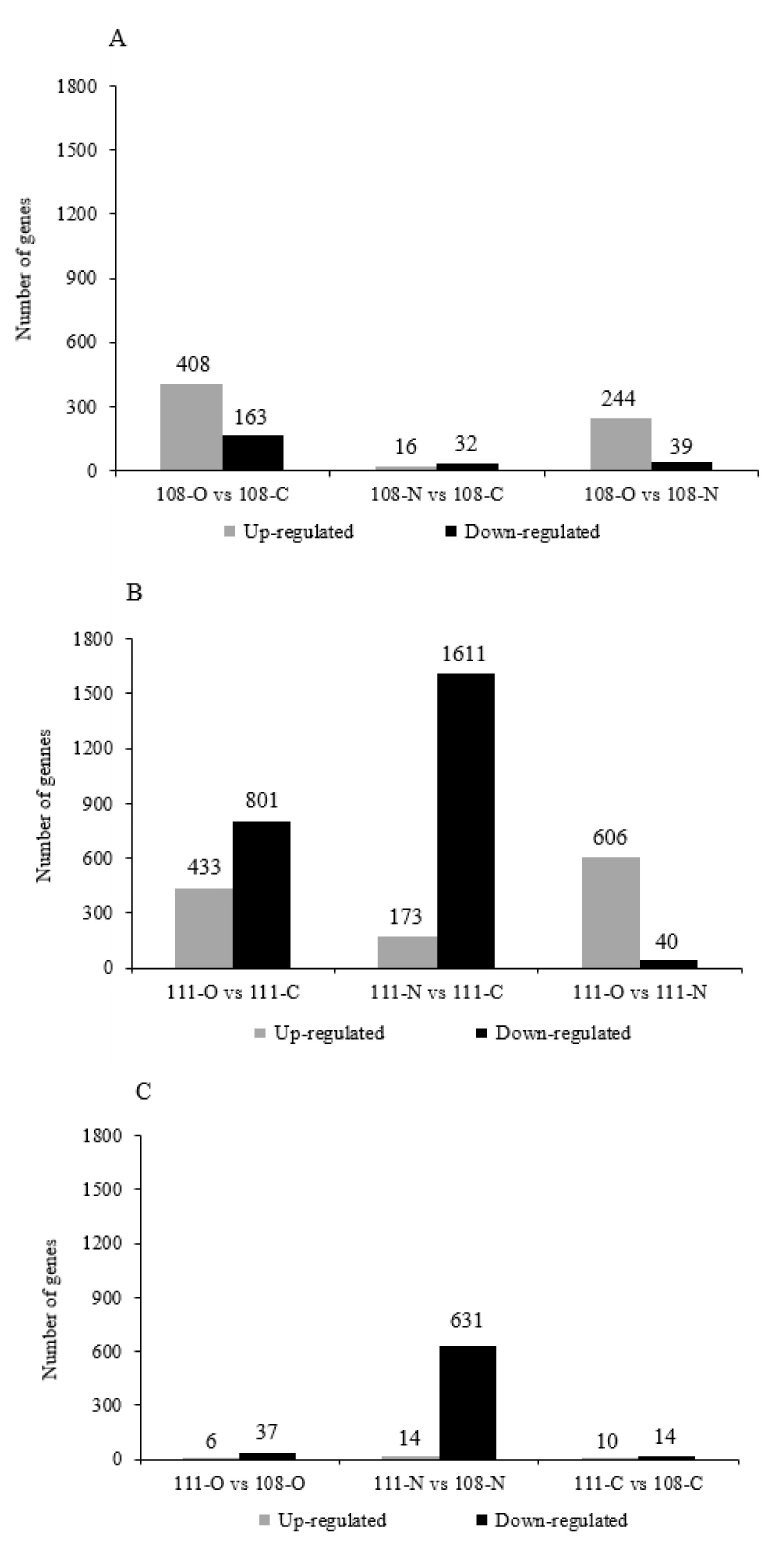
Figure 3. Di ff erential gene expression analysis of the ‘108’ and ‘111’ treatment groups. Di ff erentially expressed genes (DEGs) among ( A ) oviposited, neighboring, and control leaves of ‘108’, ( B ) oviposited, neighboring, and control leaves of ‘111’, and ( C ) oviposited, neighboring, and control leaves of ‘111’ and ‘108’. C, control; N, neighboring; O,